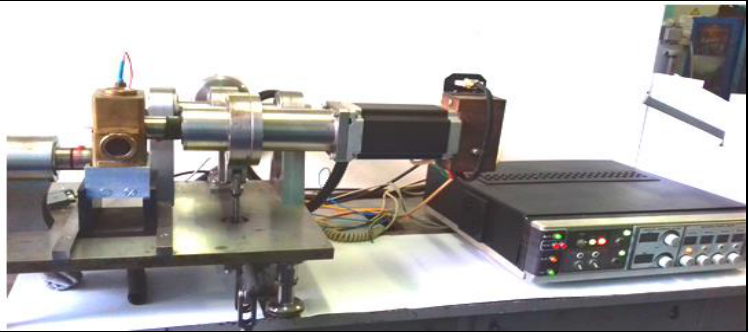
Fig. 1. Device for evaluation of tribological characteristics of